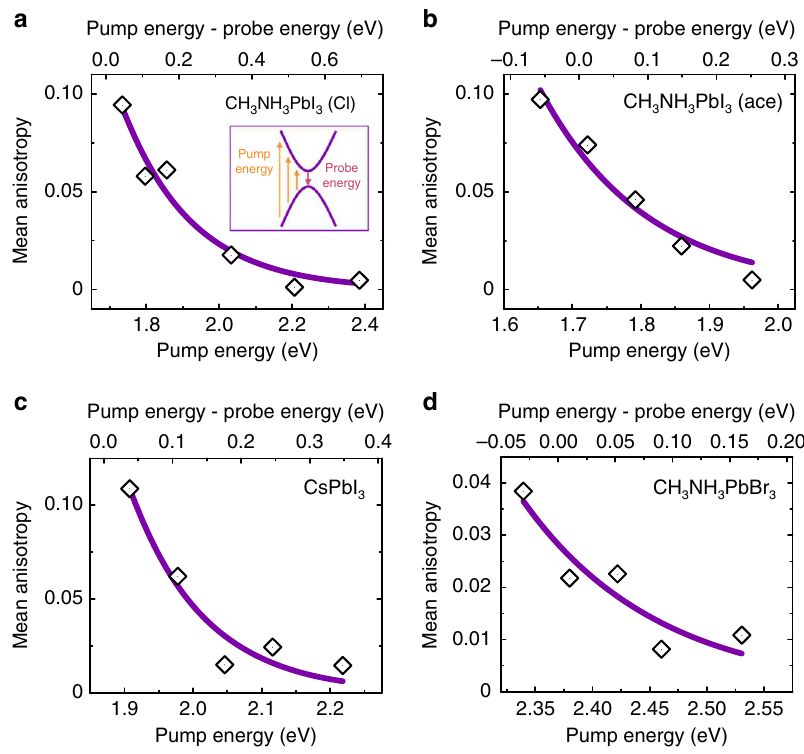
Fig. 5 Change in polarization anisotropy with pump energy. a CH 3 NH 3 PbI 3 bulk fi lms prepared with chloride precursor, b CH 3 NH 3 PbI 3 bulk fi lms prepared with acetate precursor, c CsPbI 3 nanocrystal fi lms and d CH 3 NH 3 PbBr 3 bulk fi lms. The energy per pulse was approximately 2 µ J cm − 2 (CH 3 NH 3 PbI 3 Cl), 16 µ J cm − 2 (CH µ J cm − 2 (CsPbI µ J cm − 2 (CH fi ned as the temporal and spectral 3 NH 3 PbI 3 acetate), 40 3 ), and 1 3 NH 3 PbBr 3 ). The mean anisotropy was de average of the polarization anisotropy over the fi rst 10 ps (iodide samples) or fi rst 1 ps (bromide sample), over a 40 meV probe window near the bleach maximum. The data is fi tted with single exponentials, with decay constants of 190 meV (CH 3 NH 3 PbI 3 Cl), 155 meV (CH 3 NH 3 PbI 3 acetate), 110 meV (CsPbI 3 ), and 120 meV (CH 3 NH 3 PbBr 3